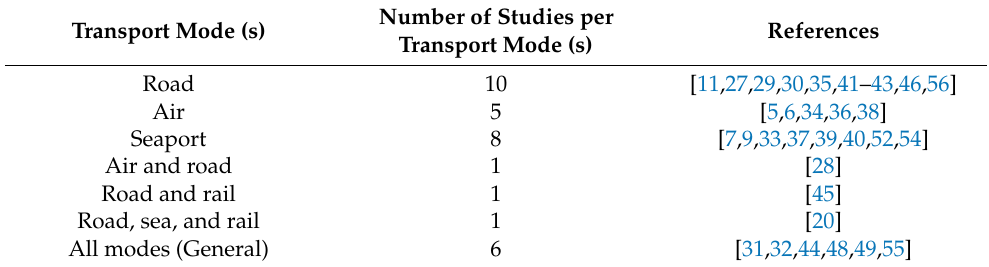
Table 5. Classification of COVID-19-related impact studies based on transport